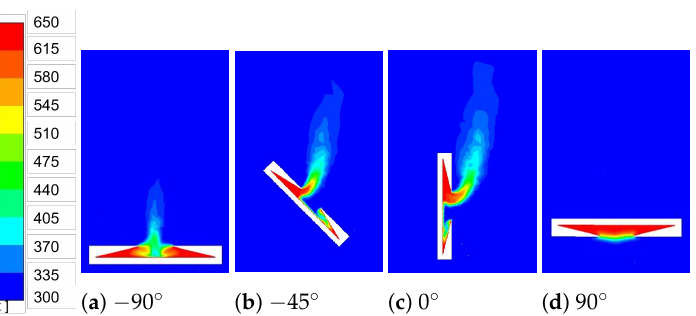
Figure 17. Section temperature contour views of the novel positive conical cavity receiver. Cavity: lateral surface isothermal steel at 650 K, base isothermal copper at 650 K; external receiver surface: isothermal at 300 K, adiabatic; body: incompressible ideal gas, ambient air at 300 K.